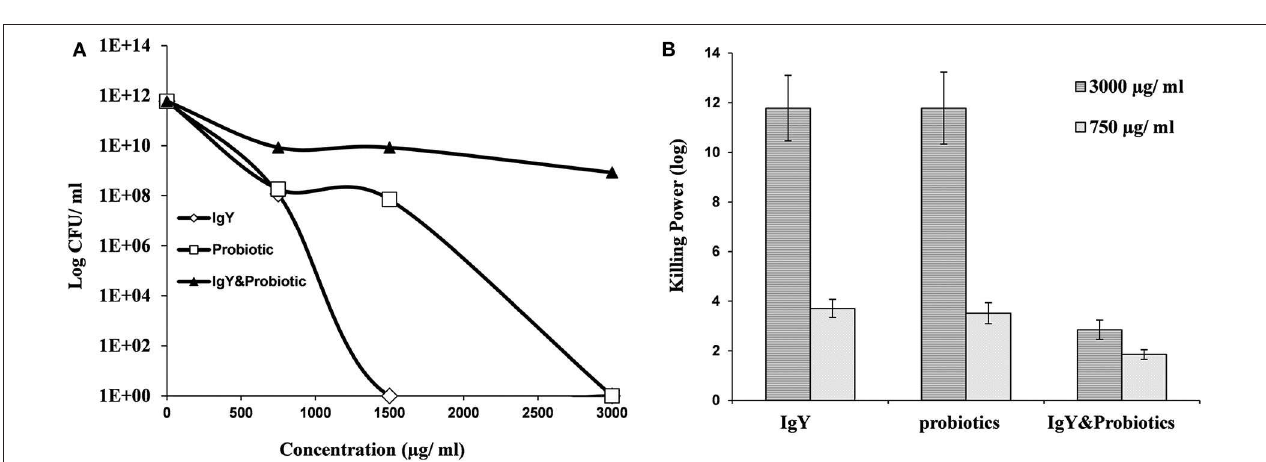
FIGURE 2 | (A) Antibacterial activity of IgY, probiotic, and the mixture of both, at different concentrations, against Staphylococcus aureus. (B) Log 10 of the antibacterial activity for the same groups at two concentrations (750 and 3,000 µ g/ml) against S. aureus .